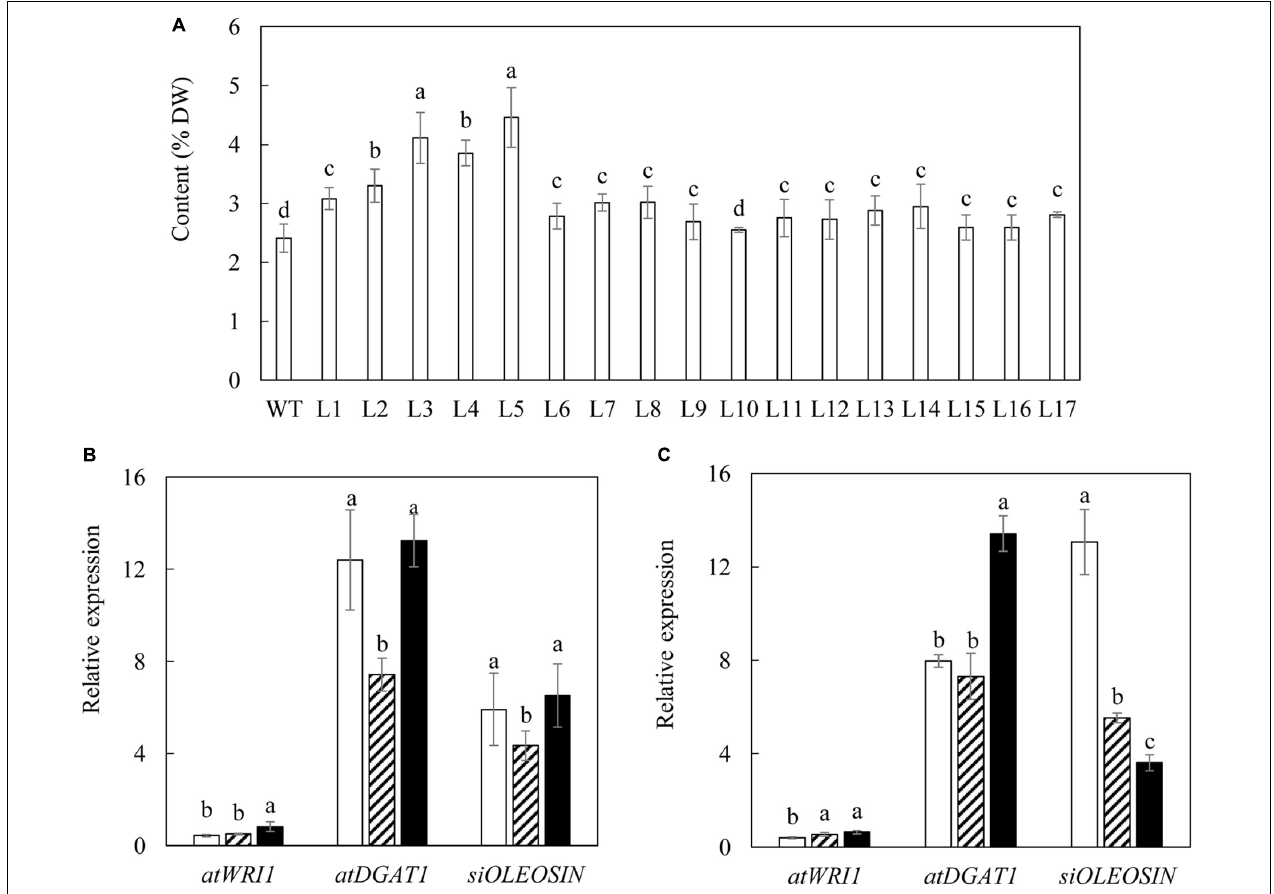
FIGURE 1 | Selection of transgenic potato plants. (A) TFA content in the senescent leaves of WT and seventeen selected transgenic potato lines at T 0 generation. (B,C) Real-time qRT-PCR analysis of gene expressions in the leaves of two selected transgenic lines, L3 (B) and L5 (C) , at the three developmental stages: flowering stage (open bar), mature stage (bar with upward diagonal) and senescent stage (black bar). The data represent the mean values ± standard deviation (SD) of three biological replicates. Letters (a, b, c, and d) above the bars are based on LSD, bars marked with different letters are statistically significantly different at P <